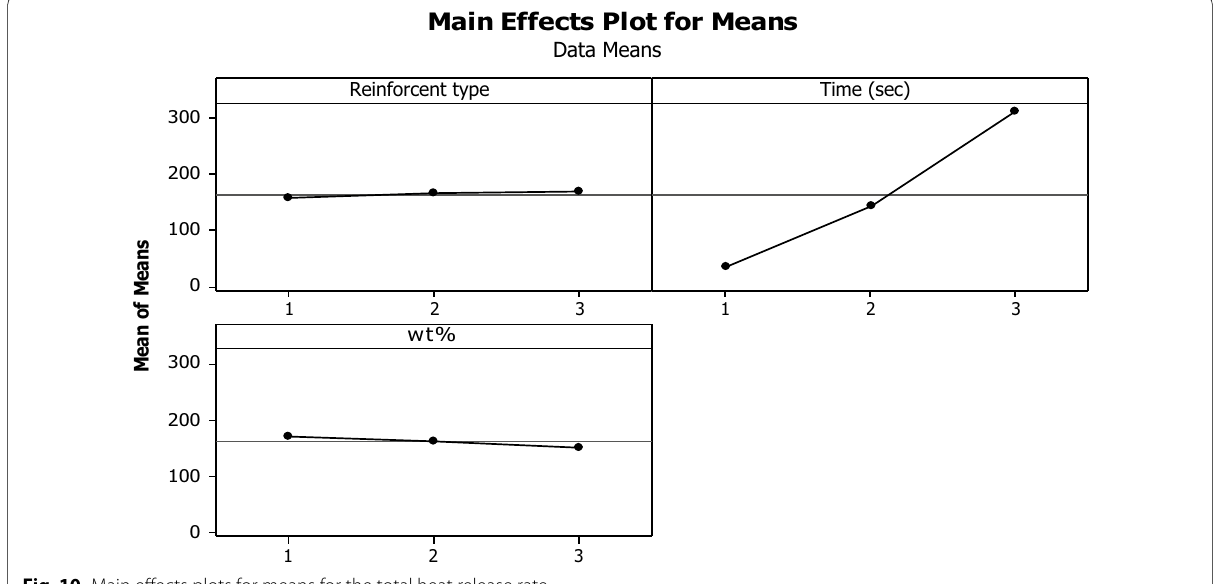
Fig. 10 Main effects plots for means for the total heat release